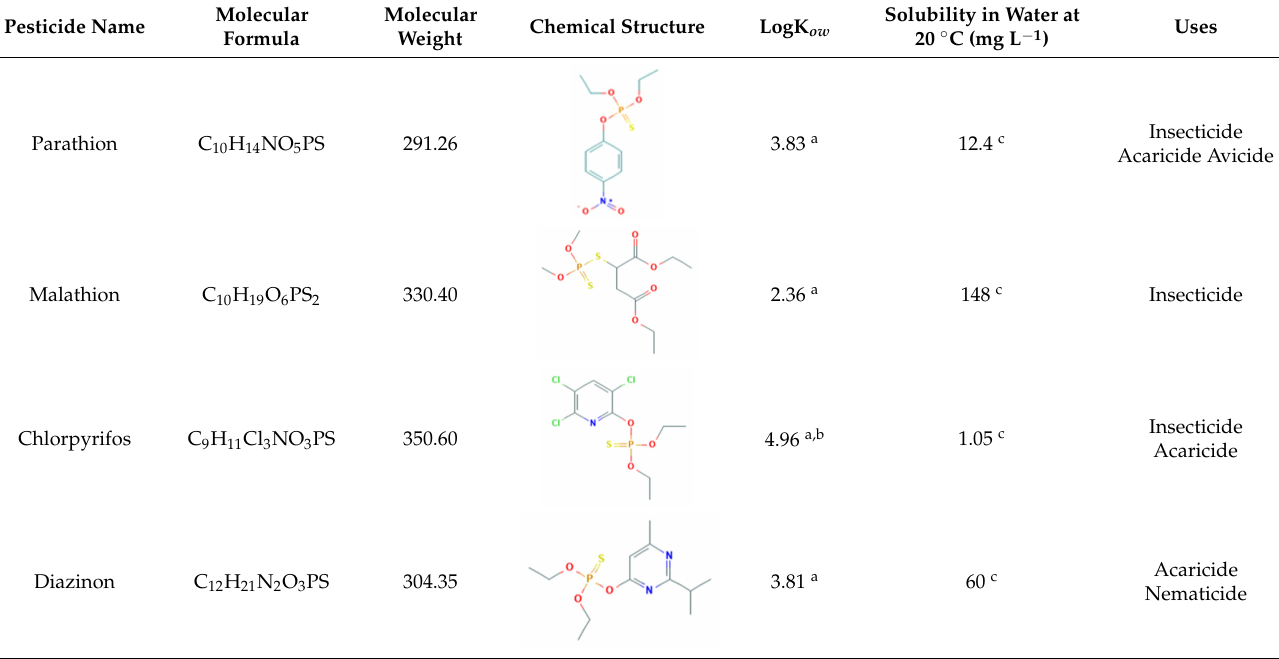
Table 1. Molecular formula and weight, chemical structure, octanol–water partitioning